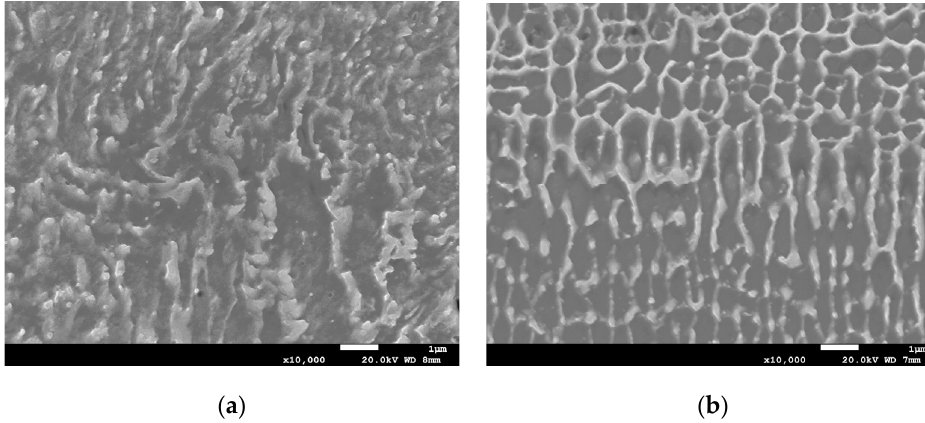
Figure 9. Metallographs of specimens with a magnification of 10,000: ( a ) N5, ( b ) N7.